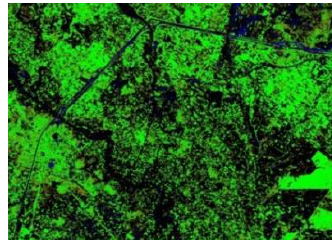
Fig. 10 Mahalanobis distance classified PALSAR data